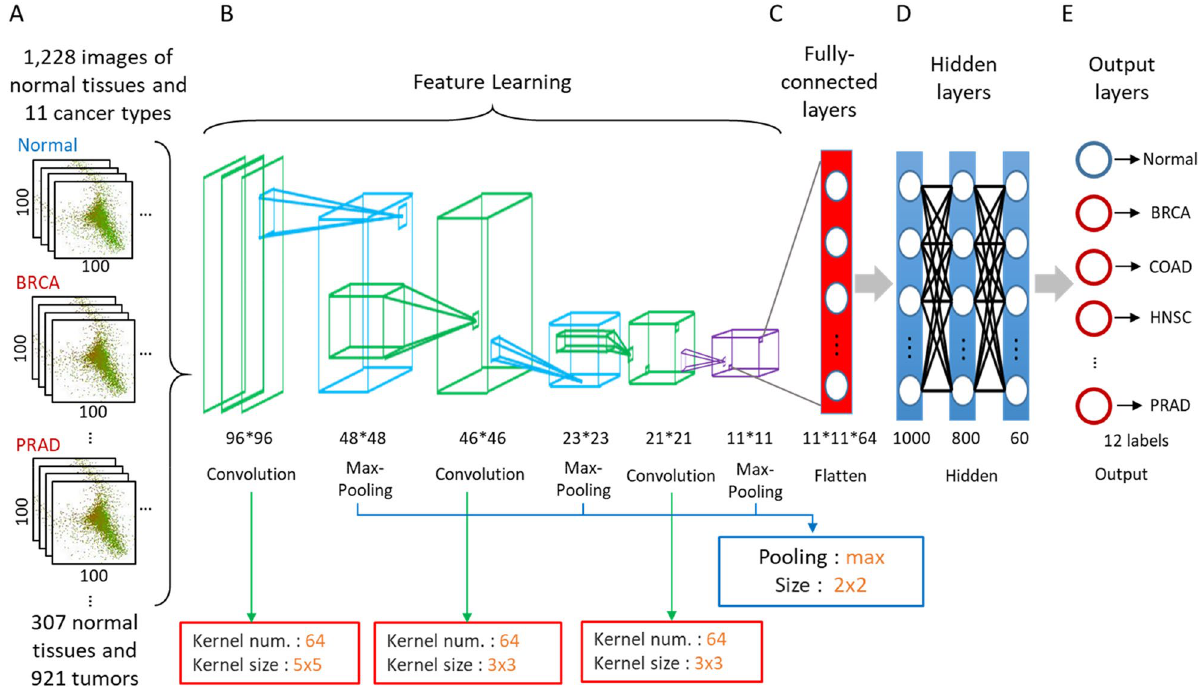
Figure 3. The CNN architecture of multiple cancer classification. ( A ) 1228 2D representation images with 100 × 100 cells were used as input data. Every image was processed with ( B ) three successive convolutional layers and pooling layers for feature learning. The obtained feature maps were ( C ) flatten to ( D ) train and ( E ) predict in fully-connected layers, hidden layers and output layers for normal tissues, tumors and 11 cancer